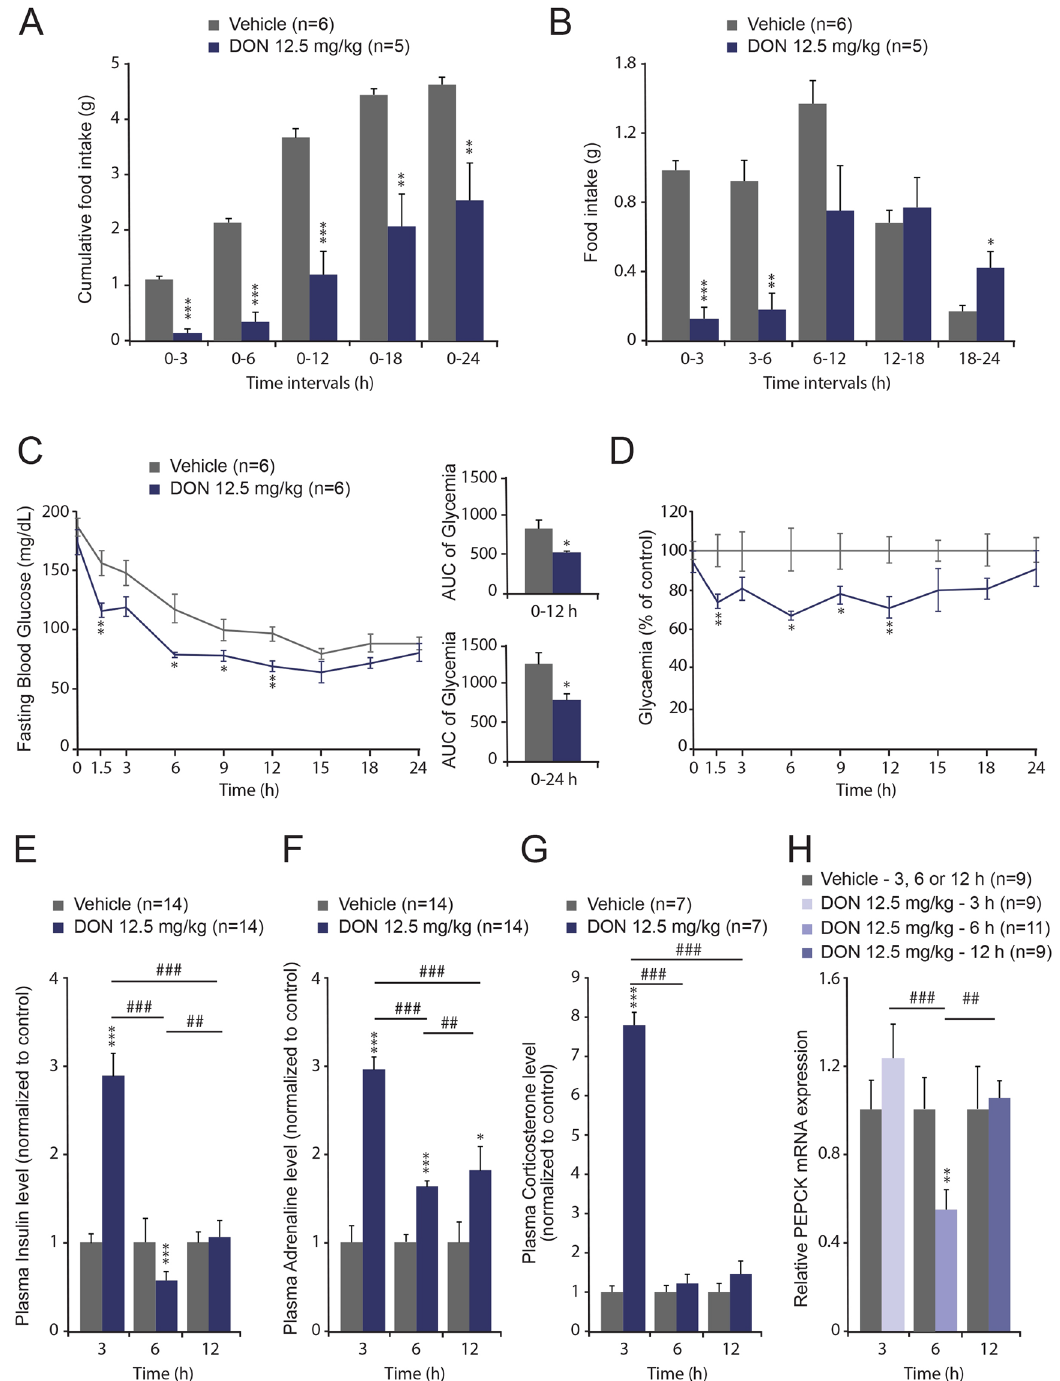
Figure 2. ( A , B ) Acute p.o. DON administration modifies food intake. Cumulative food intake ( A ) and food intake measured at different time intervals ( B ) over a 24 h period in mice p.o. administered either vehicle or DON (12.5 mg/kg bw). ( C , D ) DON-induced hypoglycemia. Time course of blood glucose concentration expressed in mg/dL ( C ) and normalized or DON (12.5 mg/kg bw, blue line, ( D ). Insets in ( C ) Area under the cure calculated for two time periods i.e. 0–12 h and 0–24 h. ( E , G ) Dosages of plasma insulin ( E ), adrenaline ( F ) and corticosterone ( G ) concentrations assayed for vehicle- and DON-treated animals. ( H ) mRNA expression of Pck1 assessed by qRT-PCR from the livers of control and DON-challenged animals for the indicated times. A two-way analysis of variance test was performed between time series (3, 6 and 12 h) of DON-treated and untreated mice (panels A , B and E – H ). Comparisons between data from vehicle and DON-treated mice were performed using unpaired 2-tailed Student’s t test (panels C , D ). * P < 0.05 ** P < 0.01 and *** P < 0.001 significantly different from control mice. # P < 0.05, ## P < 0.01 and ### P < 0.001 significant difference between time point of DON-treated